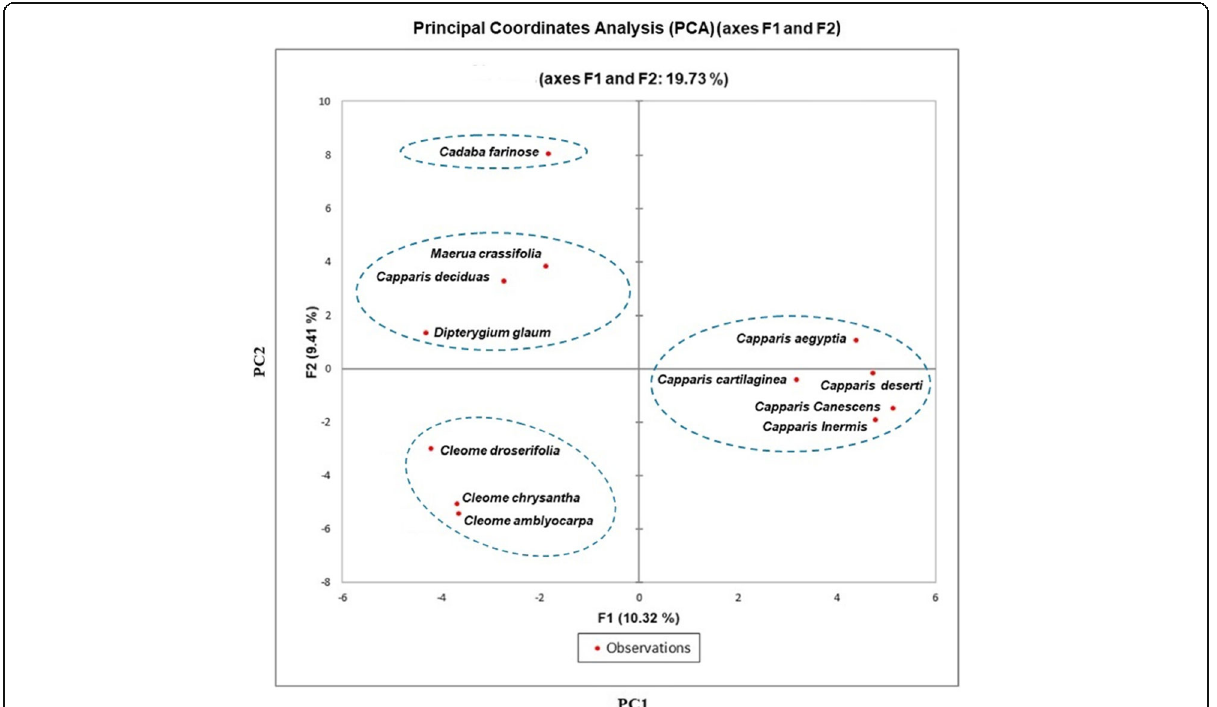
Fig. 6 Schematic representation the principal coordinates analysis of 12 Capparaceae species based on ISSR, SRAP and ISTR markers. PC1and PC2 refer to the first and second principal component,